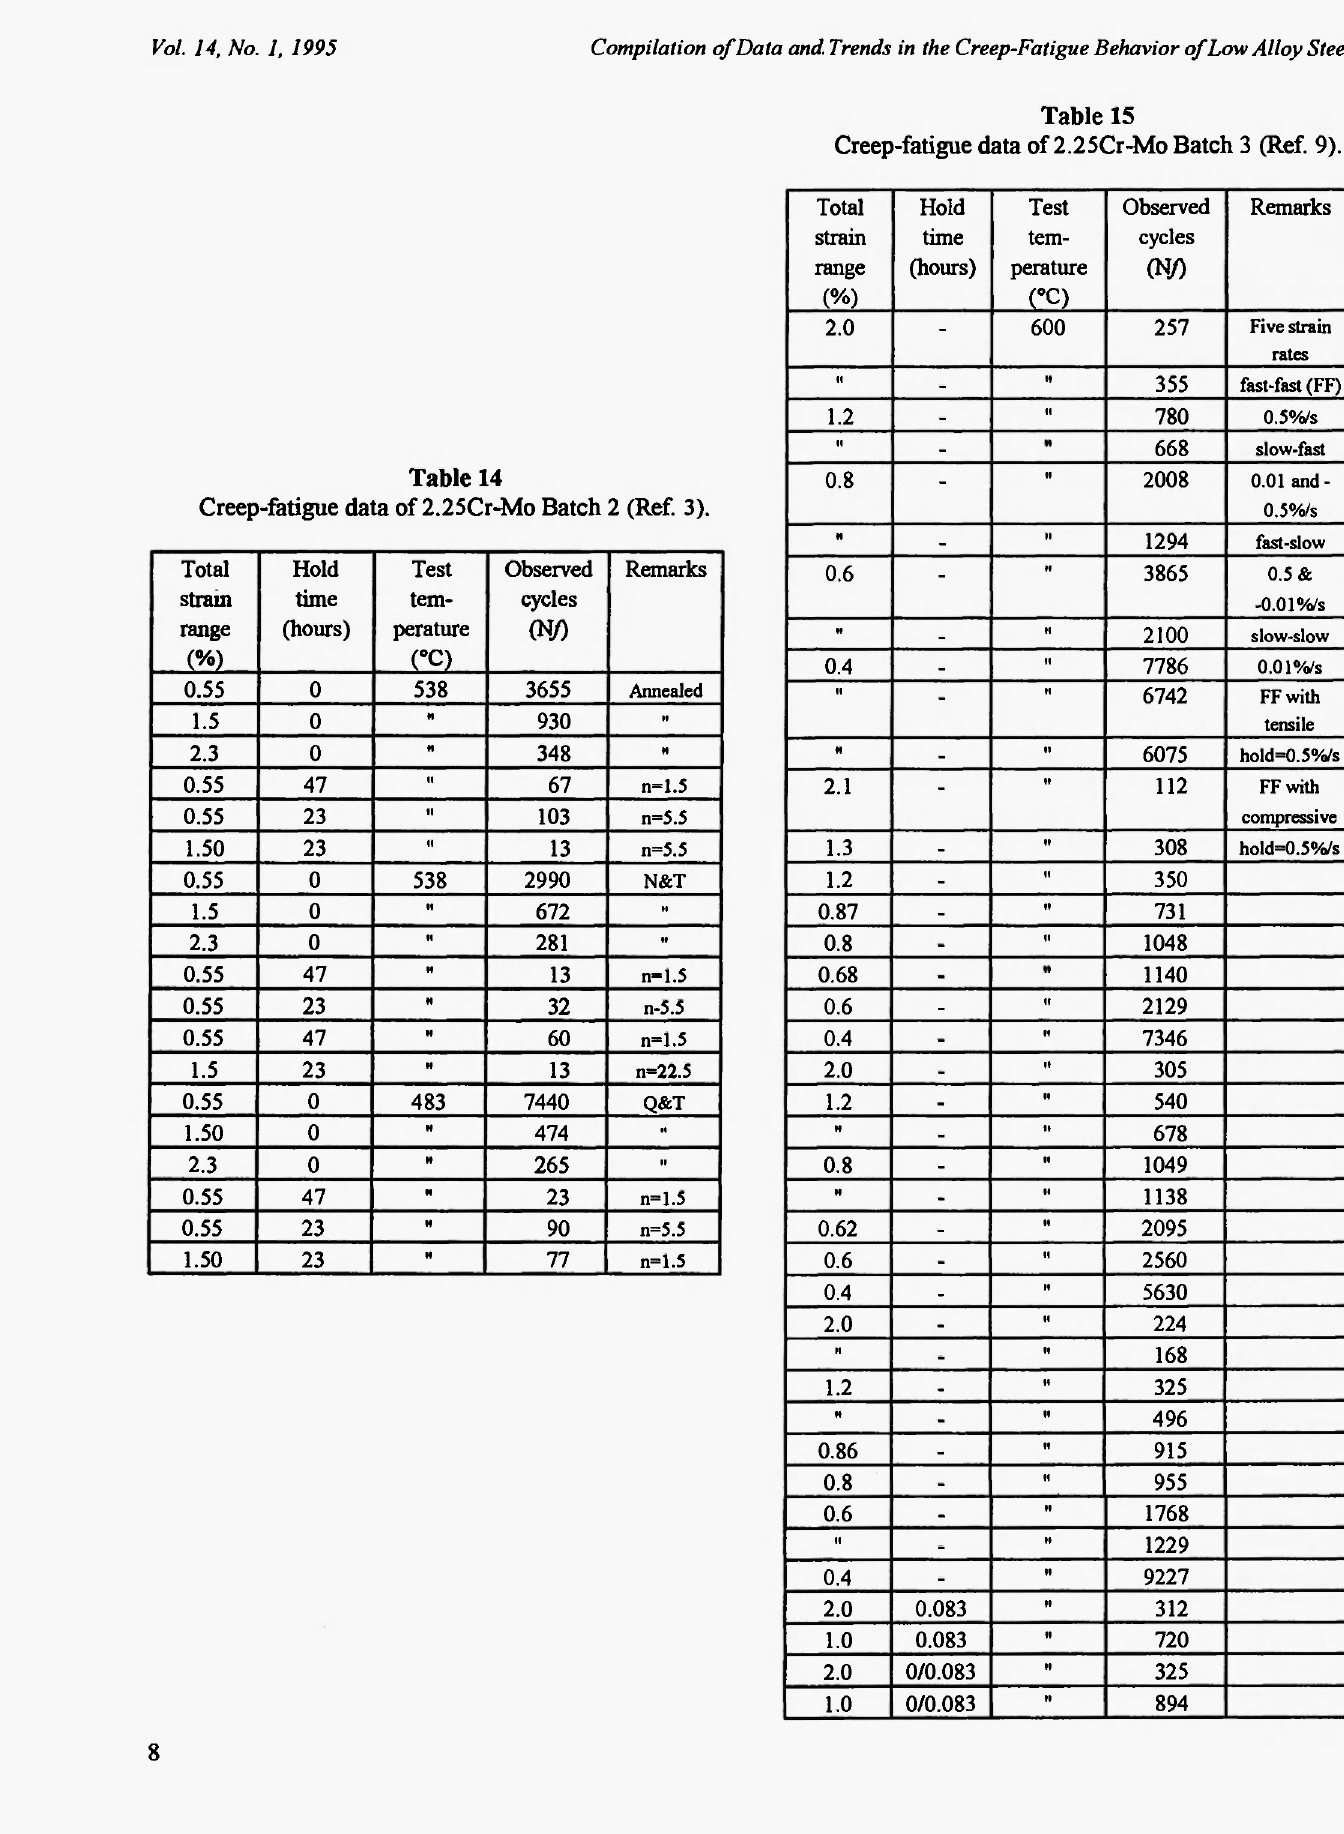
Creep-fatigue data of2.25Cr-Mo Batch 3 (Ref.